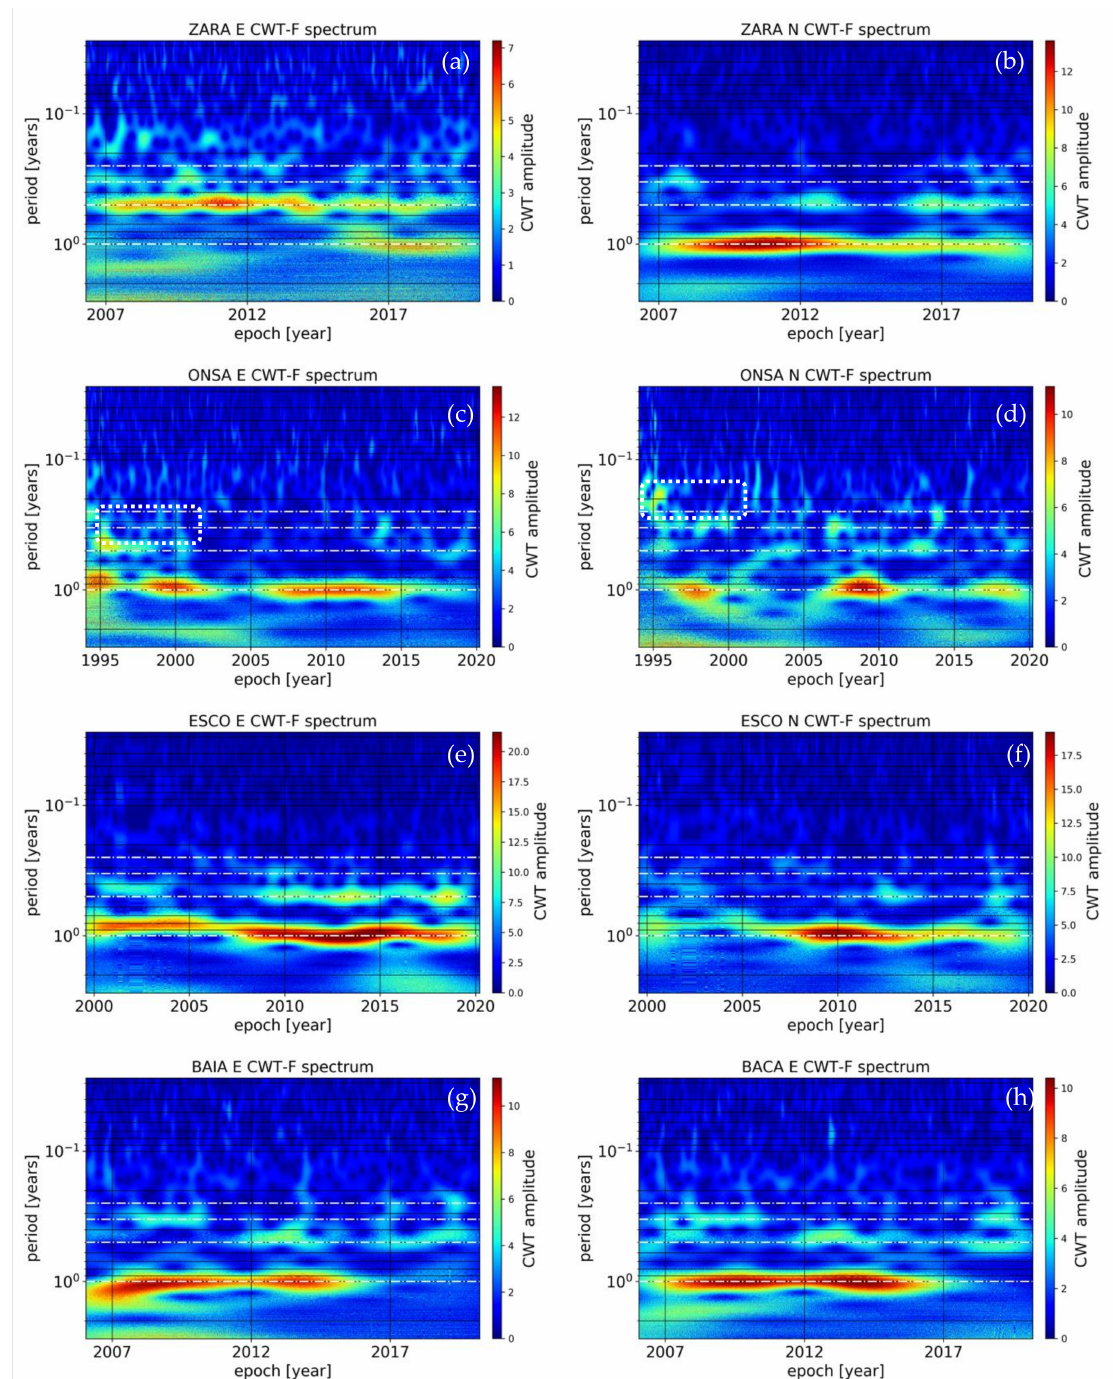
Figure 9. ( a – h ) Time–frequency spectra using CWT of the North and East components of the ZARA, ONSA and ESCO stations and the East component of the BAIA and BACA stations. The white dash-dot lines correspond to the tropical year and its 2nd, 3rd and 4th harmonics (bottom to